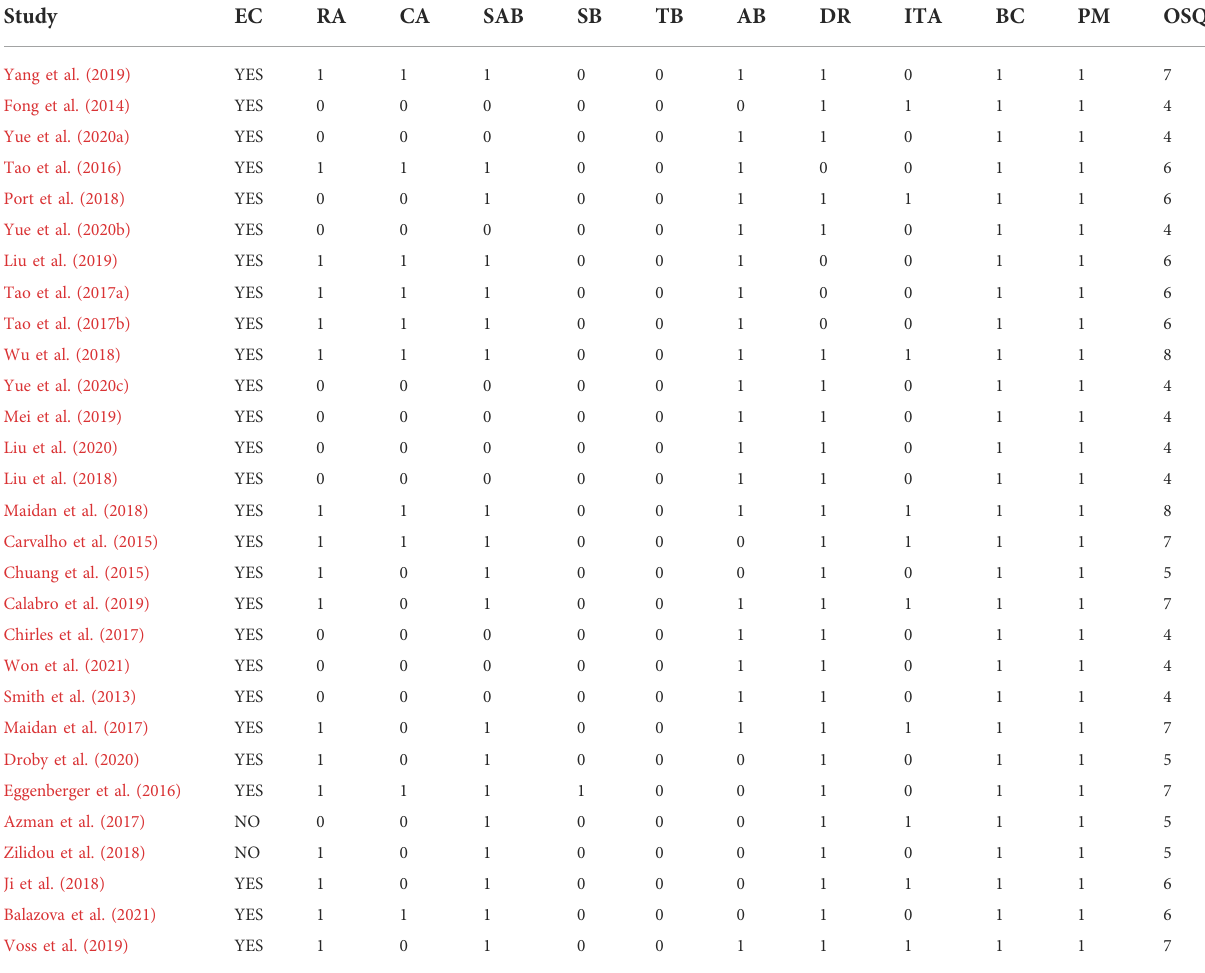
TABLE 4 PEDro scale of quality for eligible